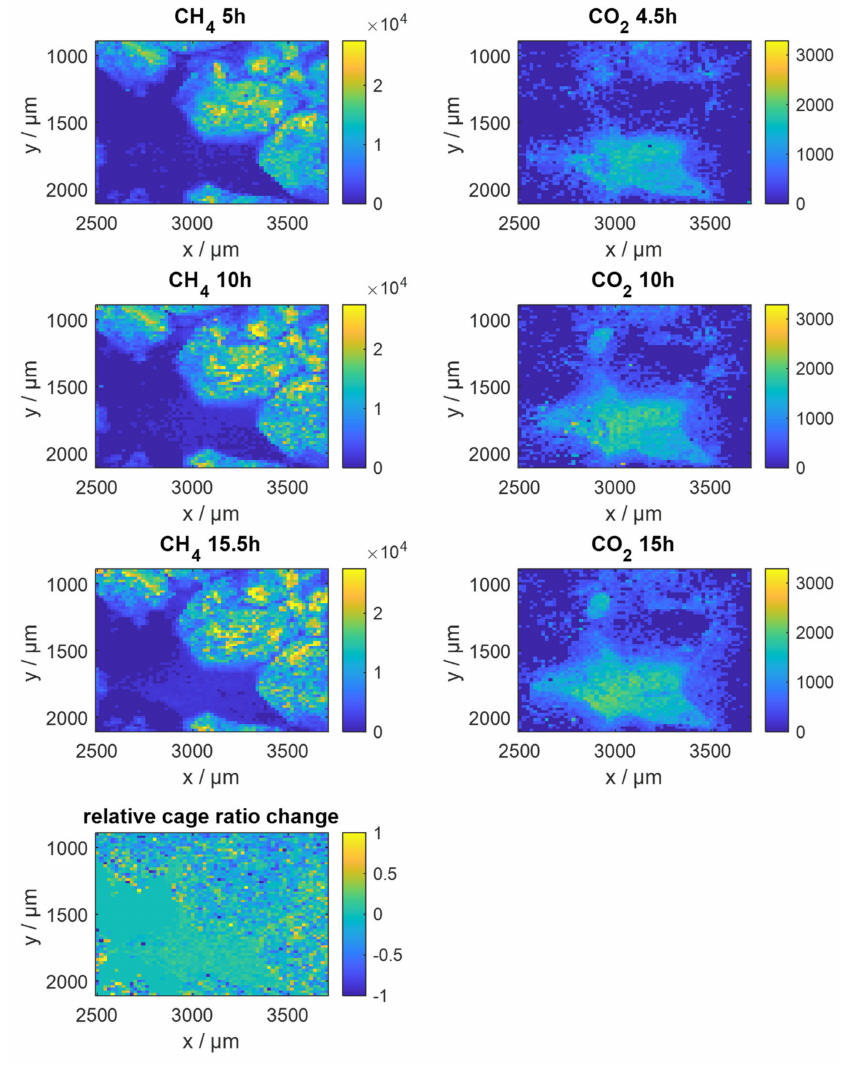
Figure 14. CH 4 and CO 2 hydrate maps of experiment Flow during the no-flow period at 5 h, 10 h, and 15 h, and the relative change in the cage-occupancy ratio during the period 5 h to 15